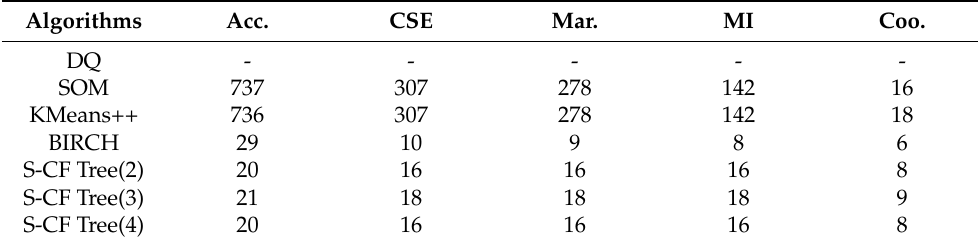
Table 2. Complexity tests (#hops) without feature